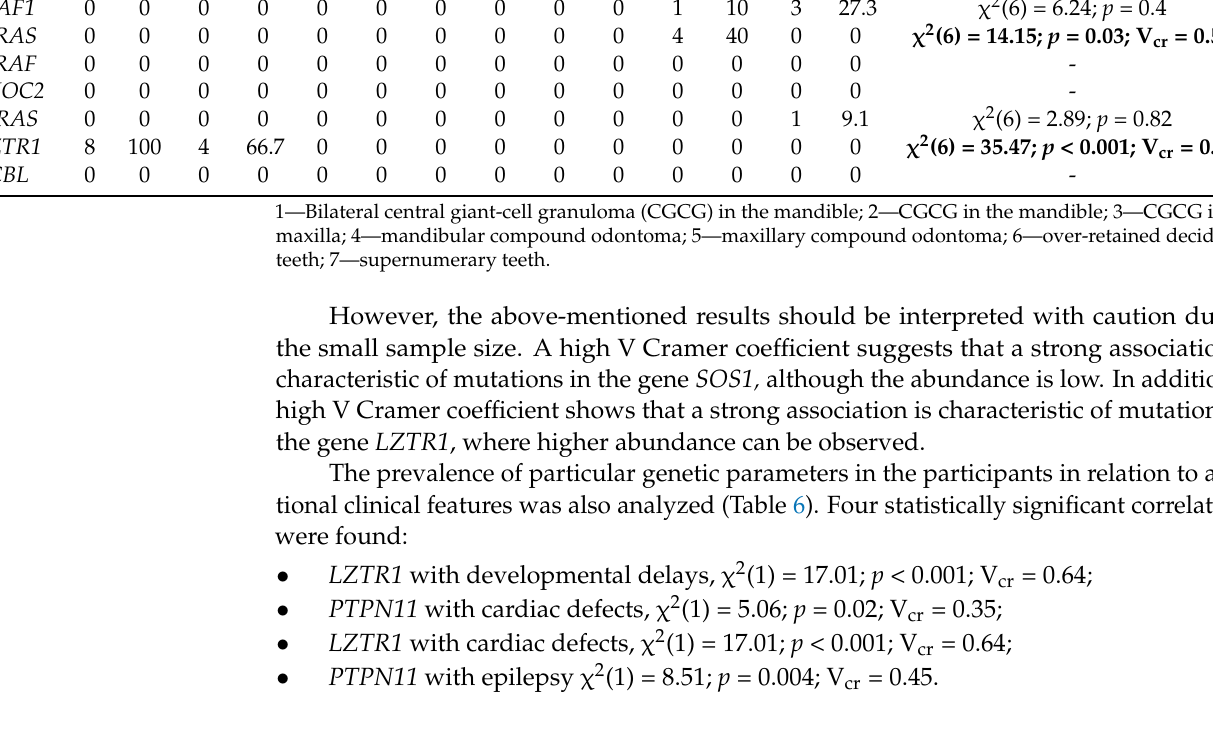
Table 6. Incidence of individual genetic parameters in the studied group, divided according to additional clinical